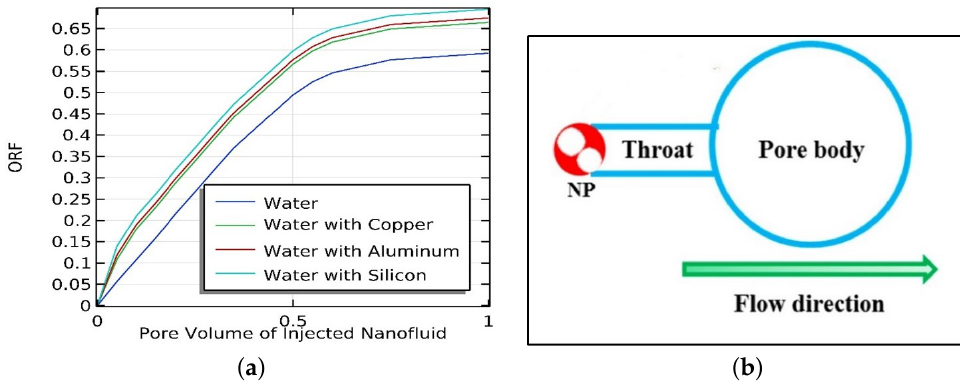
Figure 15. ( a ) ORFs for PV of water with different NPs of vol. 4% at 293.15 K, ( b ) NPs block the pore small throat for EOR.